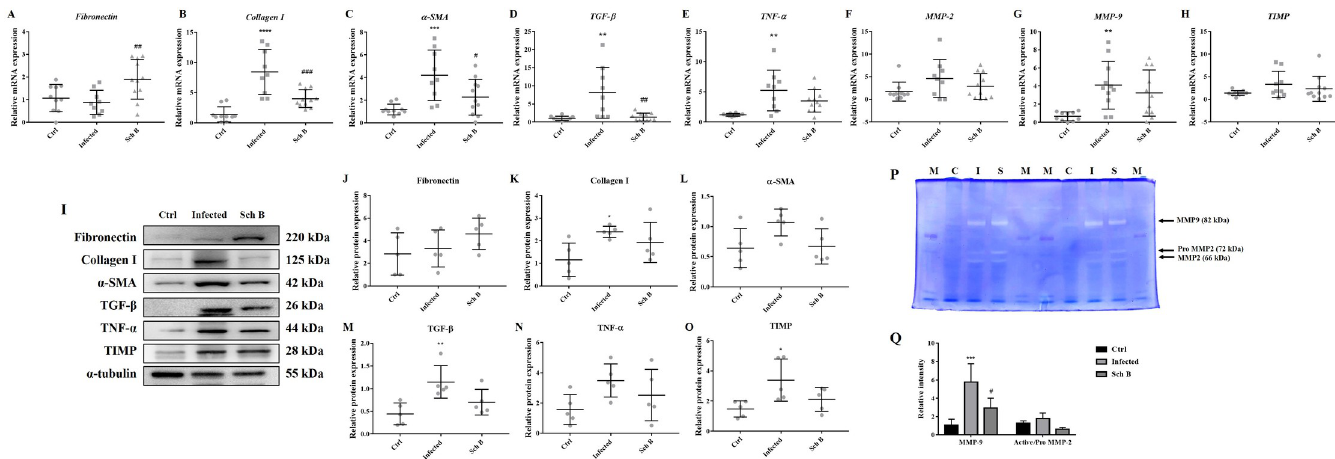
Fig 2. Sch B downregulates fibrotic genes and protein expression in S . mansoni -infected mice. (A-H) RNA transcription levels of fibrotic markers including fibronectin , collagen I , α -SMA , TGF- β , TNF- α , MMP-2 , MMP-9 , and TIMP , measured by qPCR. Data are presented as mean ± S.D. (n = 9–11). (I) Representative western blot images showing protein levels of fibrotic markers. (J-O) Protein expression levels of fibrotic markers, relative to that of α -tubulin. Results are presented as mean ± S. D. (n = 5). (P) MMP-2 and MMP-9 activities were detected by gelatin zymography. The activities were detected as unstained bands on a blue background. M, markers; C, control group; I, infected group; S, Sch B-treated group. Two independent experiments were shown. (Q) The bands were quantified by densitometry using image J. Results are presented as mean ± S.D. (n = 3). � P -value < 0.05, �� P -value < 0.01, ��� P -value < 0.001, and ���� P -value < 0.0001 compared with control group; # P - value < 0.05, and ### P -value < 0.001 compared with infected